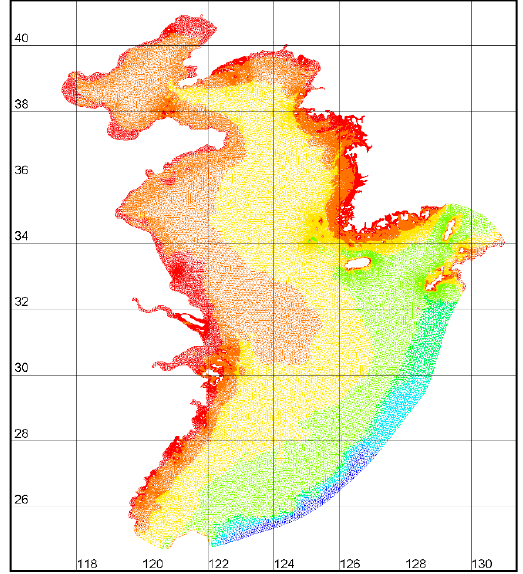
Figure 4. Bathymetry of the YECS Region.